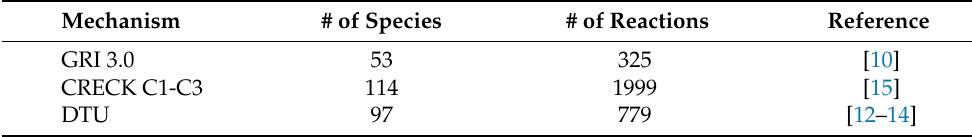
Table 2. Summary of the employed reaction